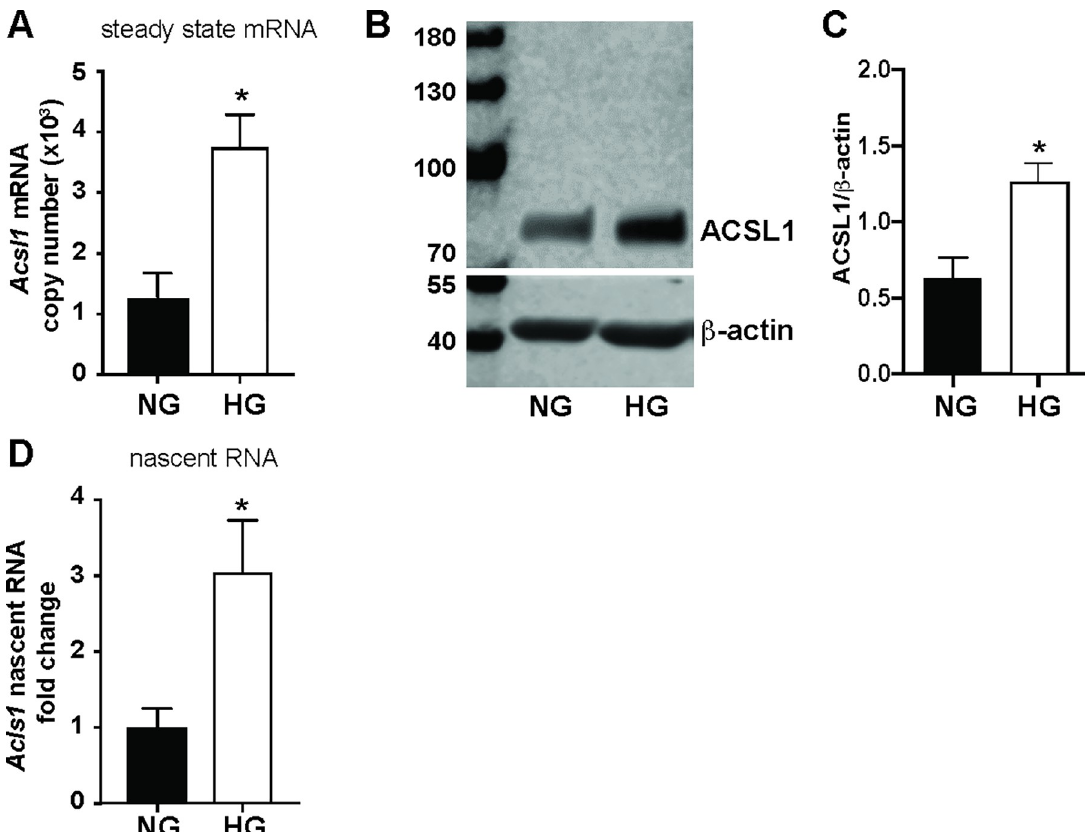
Fig 1. Acsl1 expression is upregulated in macrophages by HG. A) BMDMs were differentiated under normal glucose (NG) and high glucose (HG), and Acsl1 mRNA absolute copy number was determined by quantitative real-time PCR (qPCR) using a standard curve generated with known quantities of mouse Acsl1 cDNA. B) Western blot of total cell lysates from BMDMs cultured in NG and HG using antibodies against ACSL1 and β -actin as (loading control). C) The ratio of ACSL1/ β -actin band intensities was quantified using Image studio 5.2 (n = 3). D) Nascent Acsl1 RNA expression in BMDMs under NG and HG conditions was determined by qPCR. Nascent Acsl1 expression was quantified relative to cyclophilin A and shown as fold change. The data presented are the means ± standard error (n =